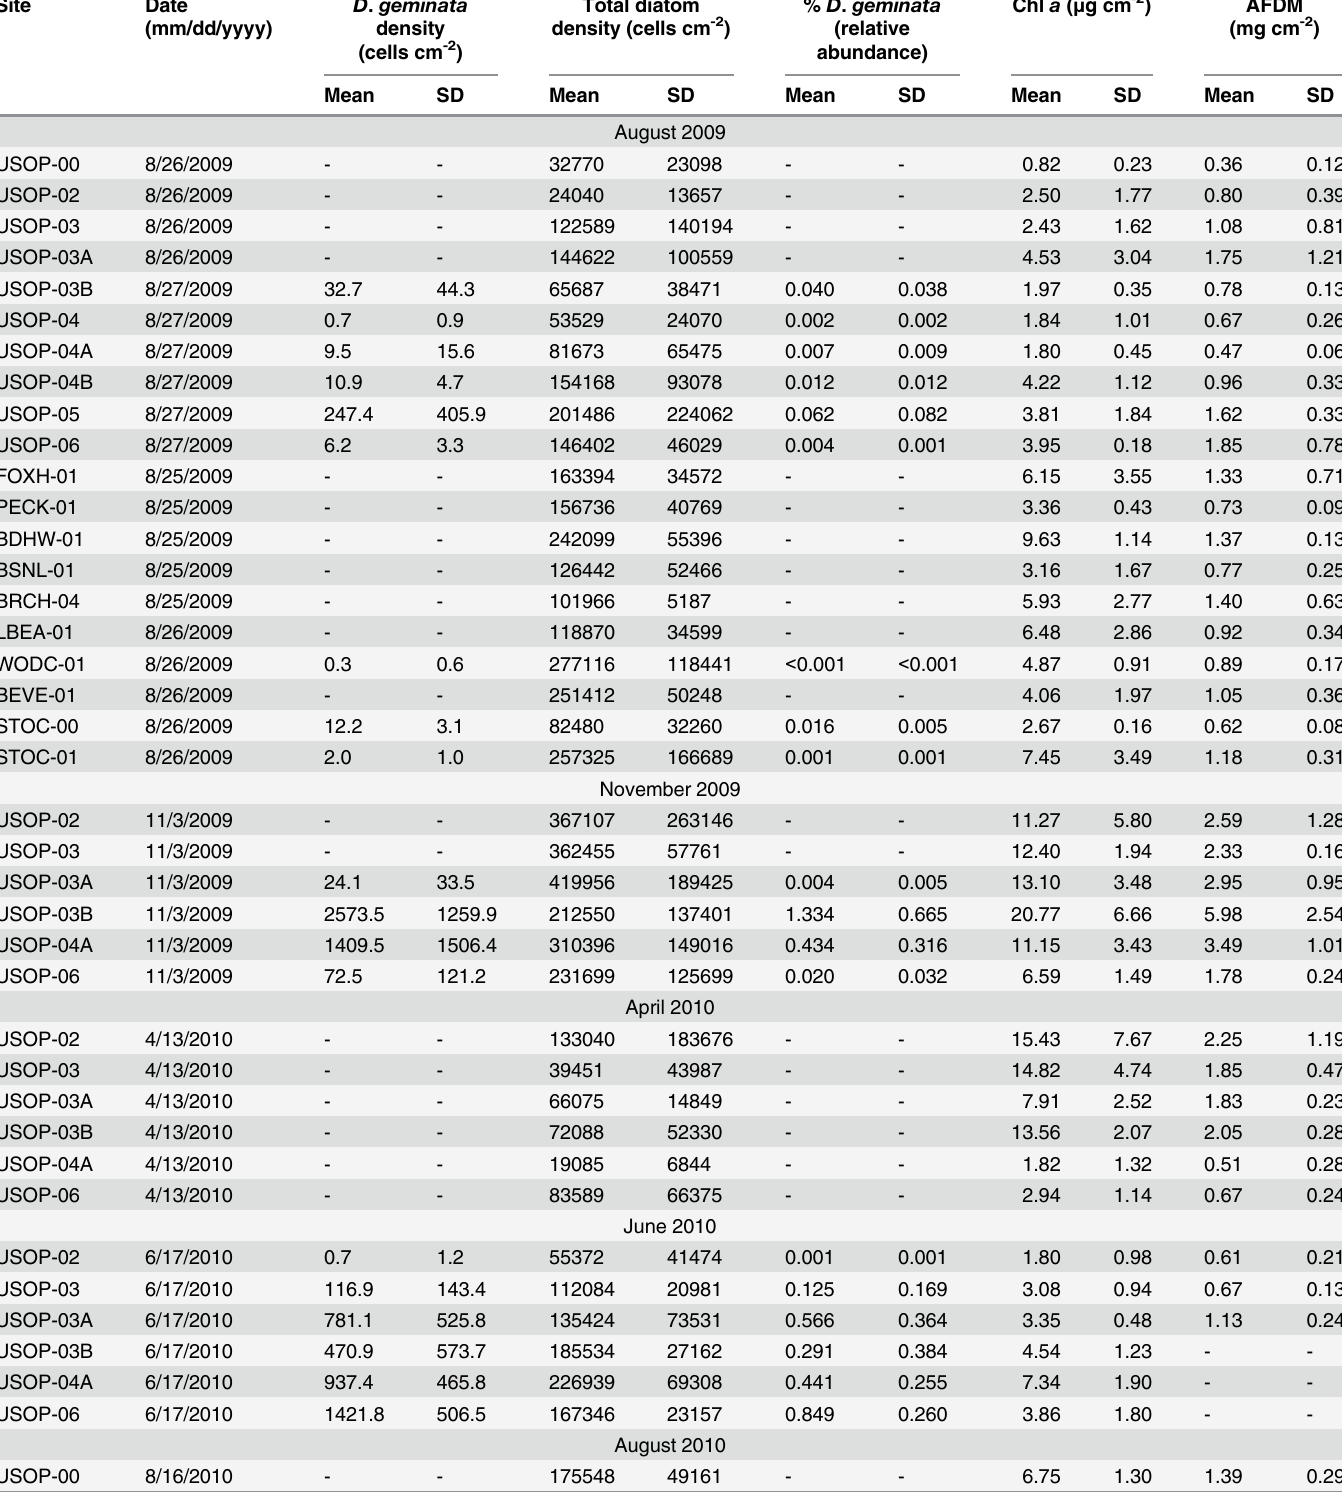
Table 3. Summary information for D . geminata density, total diatom density, percent D . geminata , chl a , and AFDM by site and survey